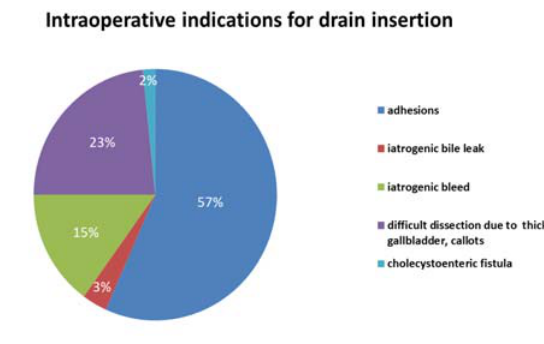
Figure 1. Pie chart diagram showing intraoperative indications for drain insertion.